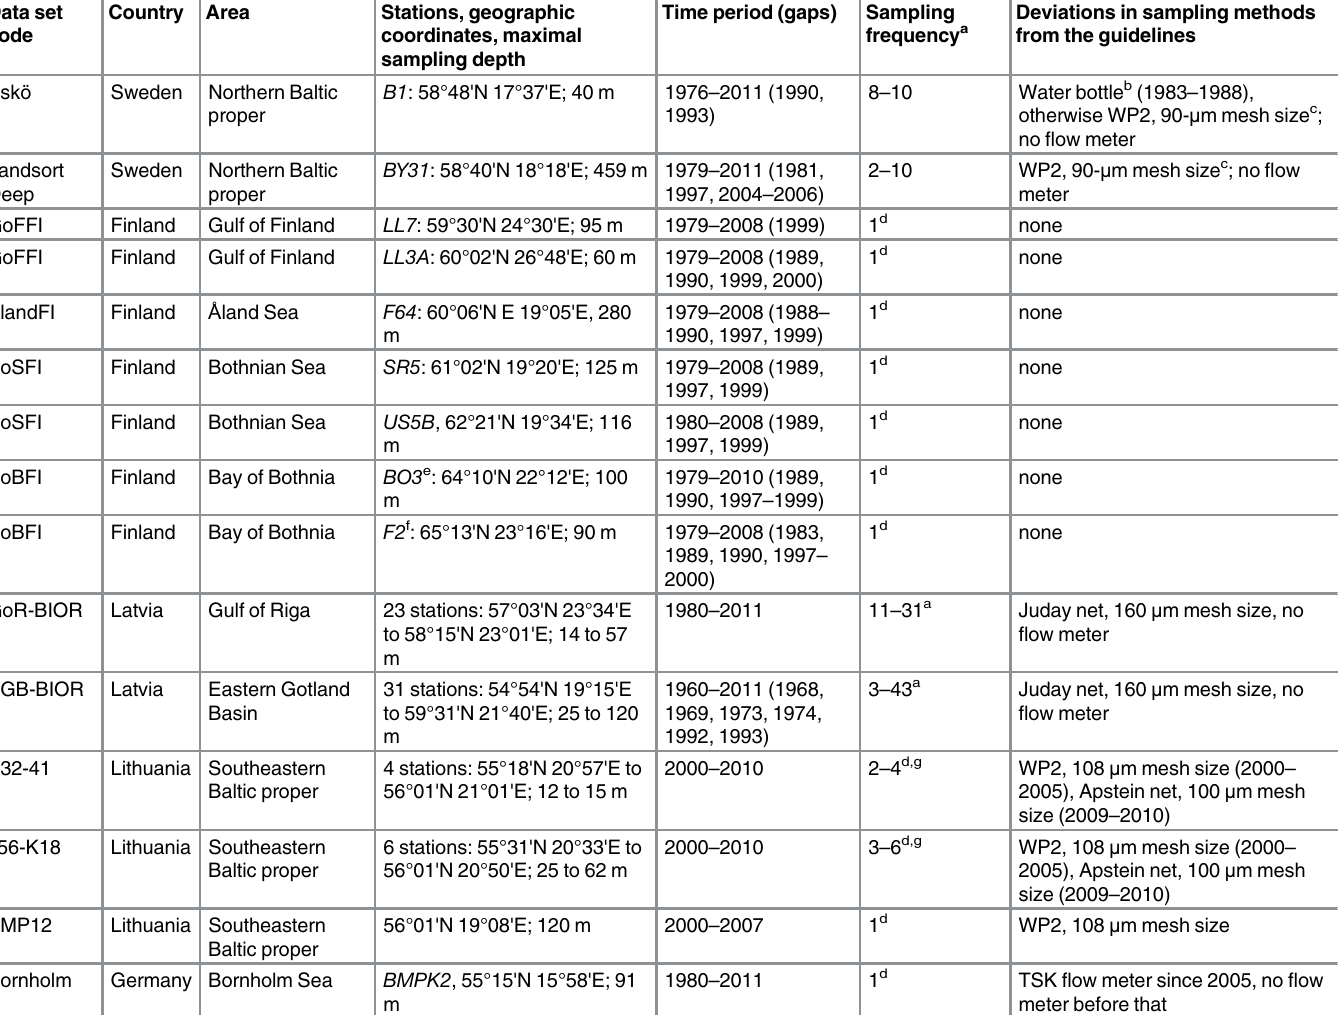
Table 1. Details for the data sets provided by national monitoring programs for indicator testing; deviations in sampling methods from the HEL- COM guidelines (i.e., WP2, 100- μ m mesh size) are indicated. See S1 Table for